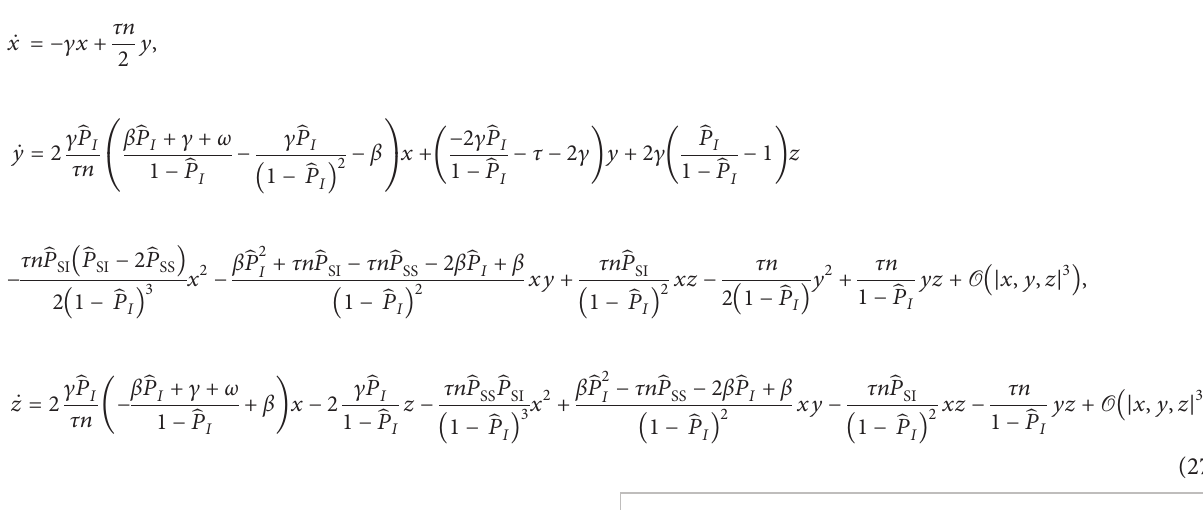
Figure 1: Bifurcation diagrams of system (5) where SN, SN ω � 2 . 9, and β � 0 (solid), 2.3 (dashed), 3.5 (dotted dash), or 15